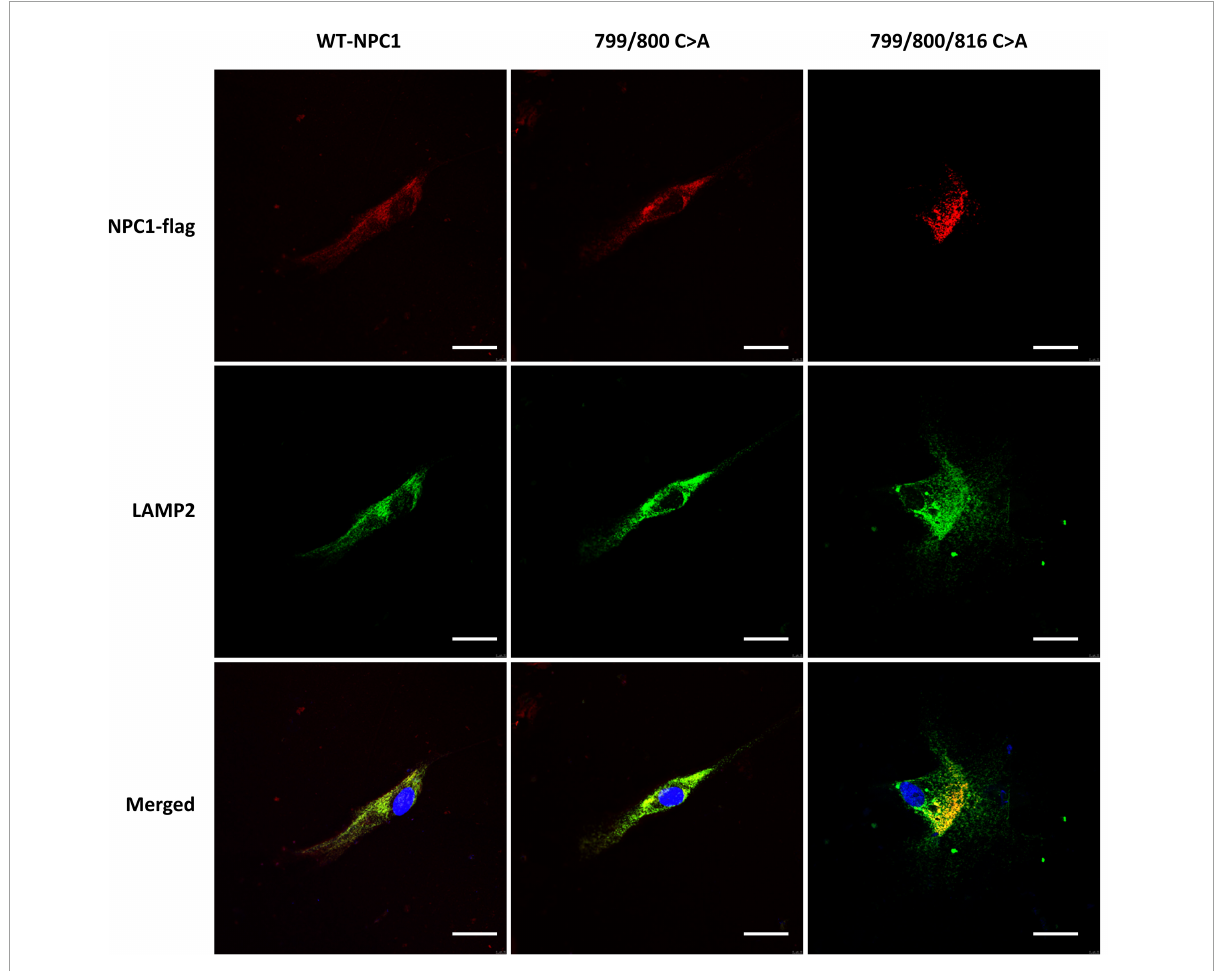
FIGURE7 Intracellular localization of mutated NPC1 protein in NPC1 mut fibroblasts. Left column : NPC1 mut fibroblasts transfected with wildtype NPC1 protein (WT NPC1). Middle column: NPC1 mut fibroblasts transfected with a.799/800 C > A mutation. Right column : NPC1 mut fibroblasts transfected with a.799/800/816 C > A mutation. The transfected NPC1 proteins were tagged with red fluorescence (top panels) and stained with LAMP2 (green fluorescence, middle panels ). The pictures were merged to show the co-localization of the proteins (bottom panel) .